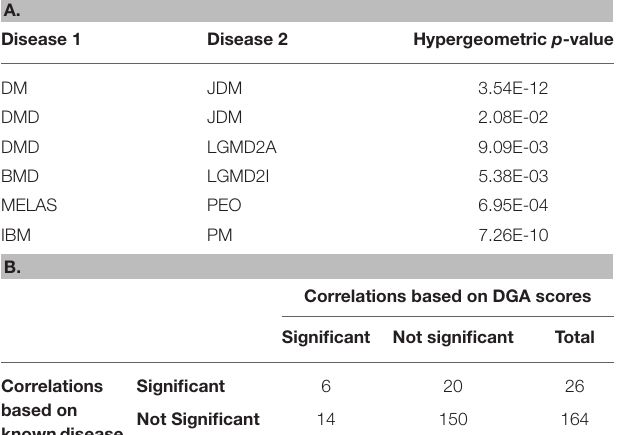
TABLE 3 | Disease association